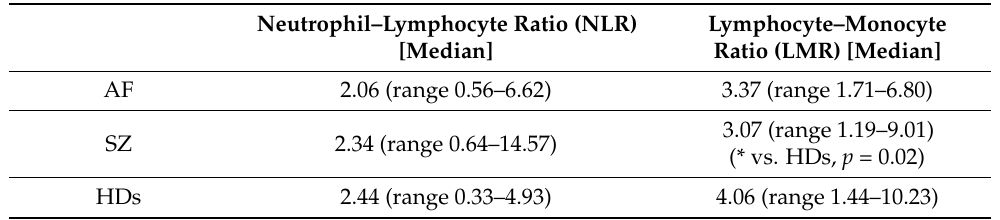
Table 1. Neutrophil–lymphocyte ratios (NLR) and lymphocyte–monocyte ratios (LMR) of patients with affective (AF) and schizophrenic (SZ) spectrum disorders, and healthy donors (HDs). Values are given as medians, including ranges. Wilcoxon rank-sum test was performed to analyze differences among groups, with significant differences being marked by * p ≤ 0.05.